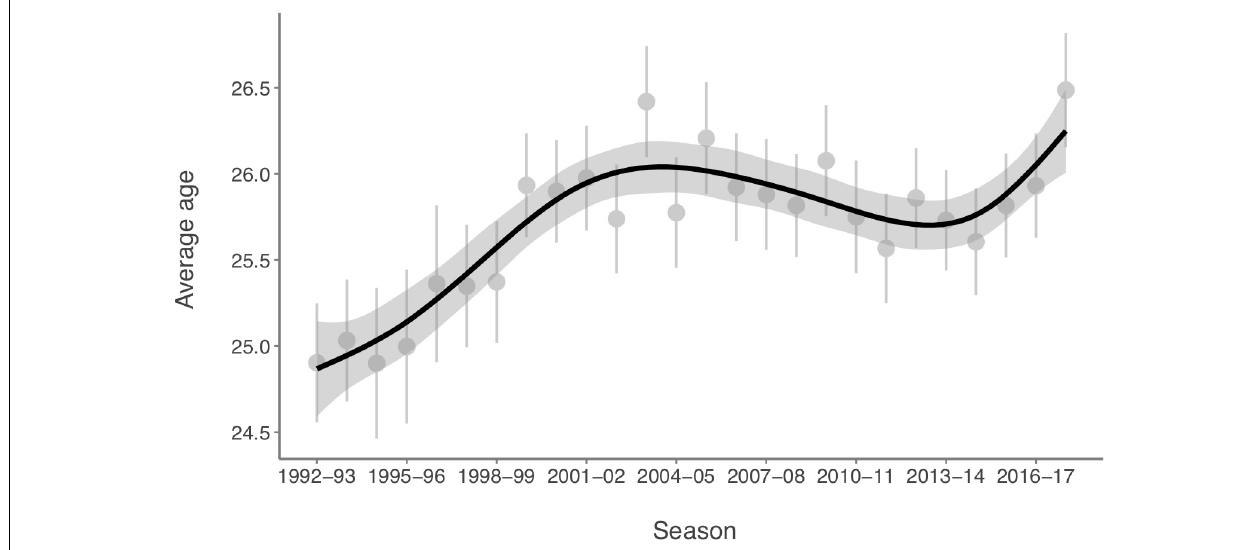
FIGURE 2 | Age trend of UEFA Champions League players.